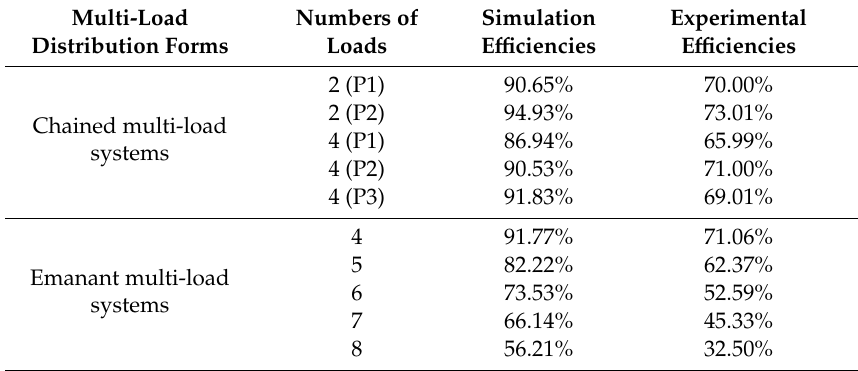
Table 4. Comparison of simulation e ffi ciencies and experimental e ffi ciencies of 5 m multi-load